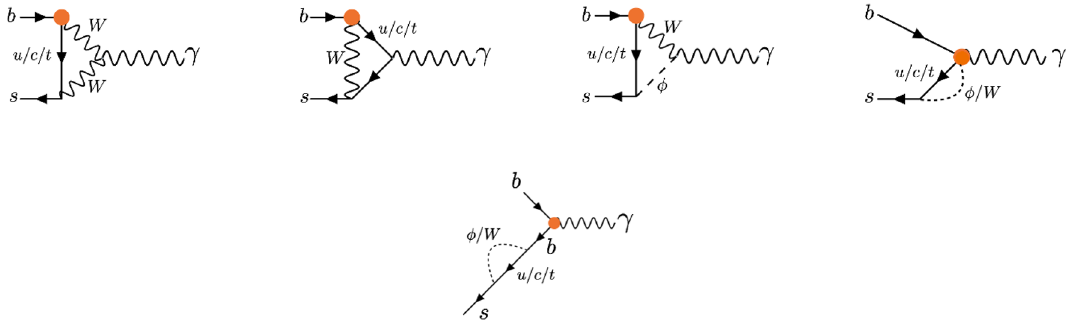
Figure 9. Diagrams generating contributions to b → sγ from the Q dW operator.